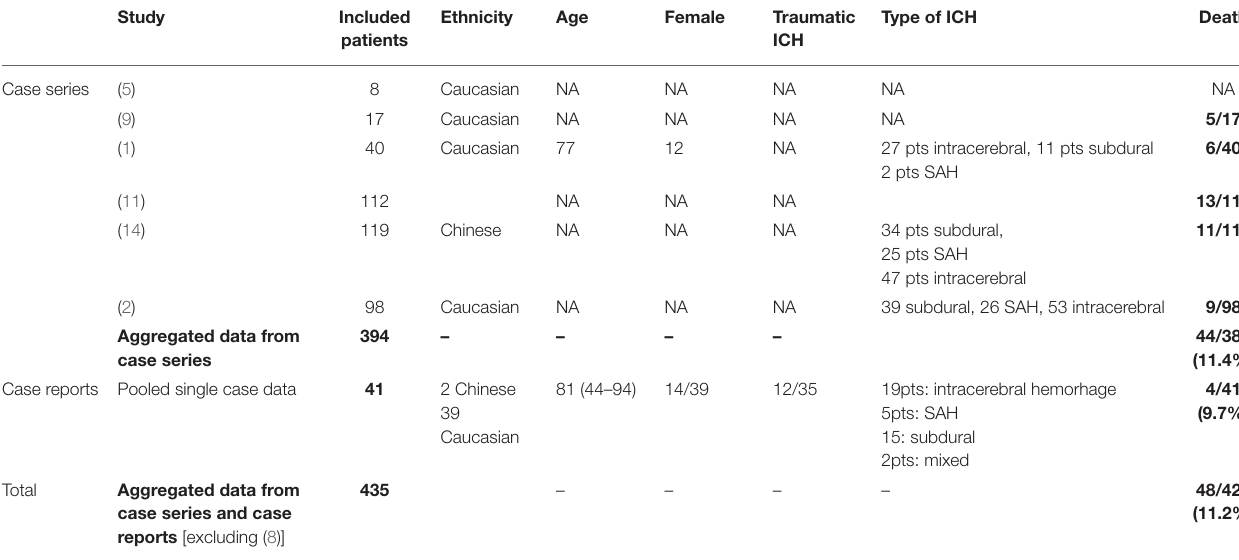
TABLE 1 | Baseline characteristics and outcomes of idarucizumab/dabigatran-treated patients with